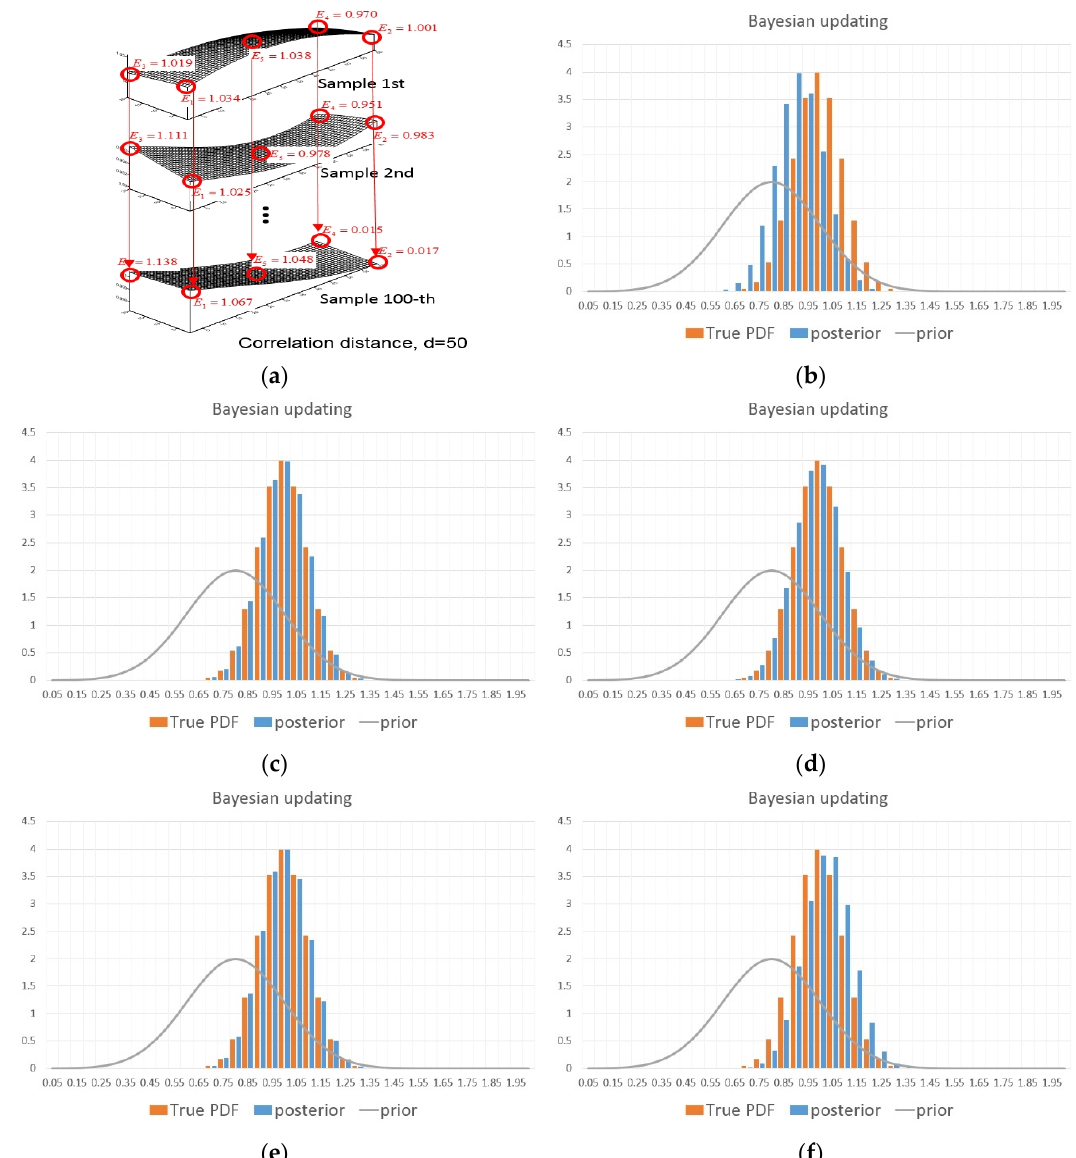
Figure 11. Bayesian updating at the stochastic field of the correlation distance d = 20.0: ( a ) How to perform Bayesian updating; ( b ) Observation point 1; ( c ) Observation point 2; ( d ) Observation point 3; ( e ) Observation point 4; ( f ) Observation point 5.